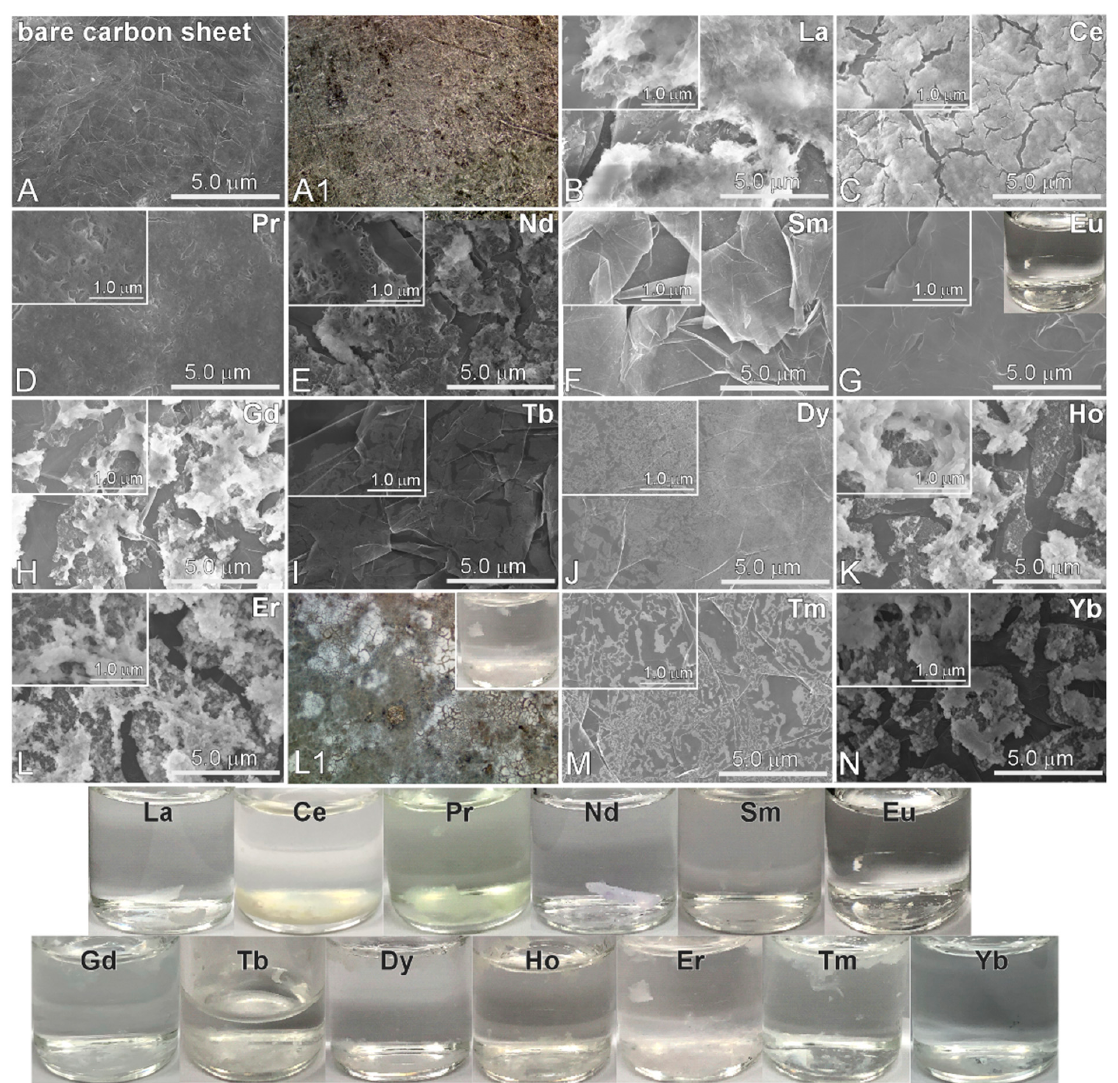
Figure 2. Scanning electron microscope images ( A – N ) for a bare carbon sheet ( A ) and electrodeposited Ln elements on carbon sheet electrodes ( B ‒ N ), optical microscope (300×) images ( A1 , L1 ), and the corresponding photos (bottom panel) of electrolytes (with precipitates) after electrodeposition.